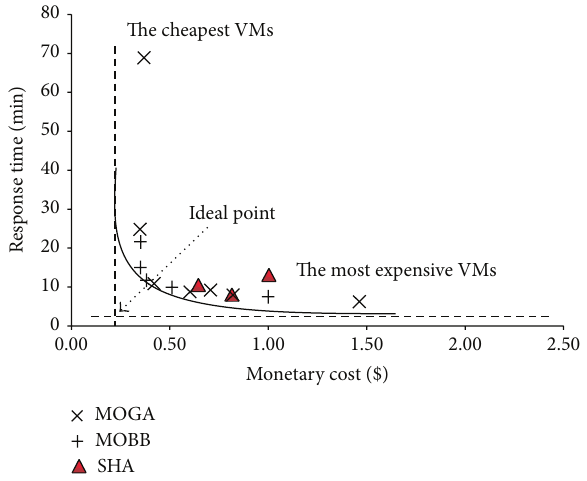
Figure15:Proposedparetooptimalsolutionsforworkload1bySHA, MOBB, and MOGA algorithms.